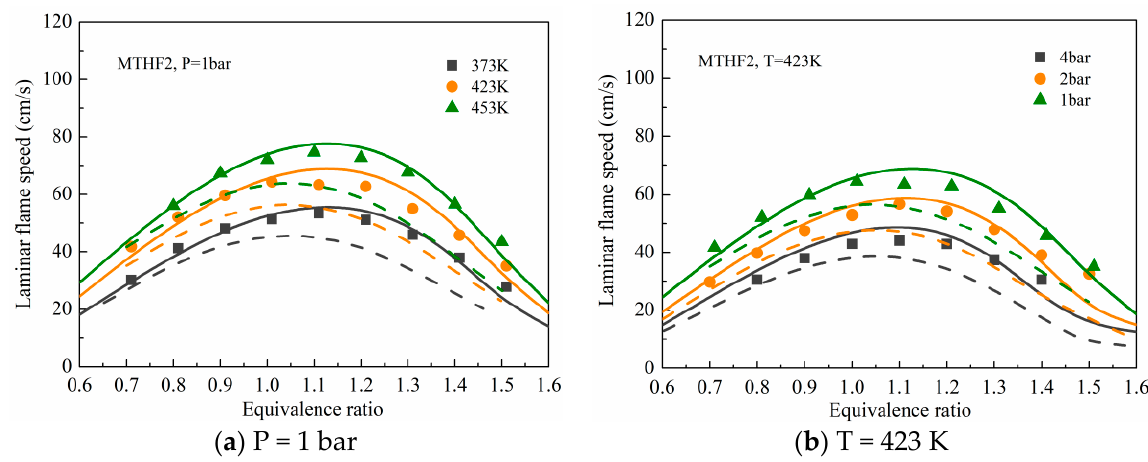
Figure 14. Measured (symbols) [36] and calculated (lines) species concentrations in a JSR for syn- thetic diesel fuel/air mixtures at 10 atm, τ = 0.5 s, φ = 0.5 and 2.0.